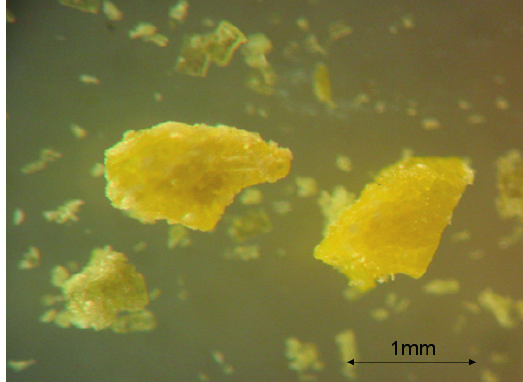
Figure 6. Crystals of 1 H -1,2,4-triazole-1-carboxamidine-5,5'-azotetrazolate ( 2